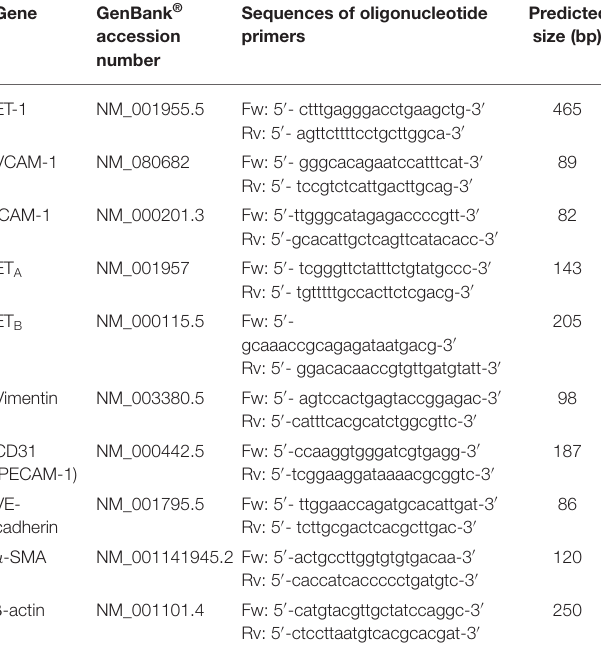
TABLE 1 | PCR primers sequences used for gene expression